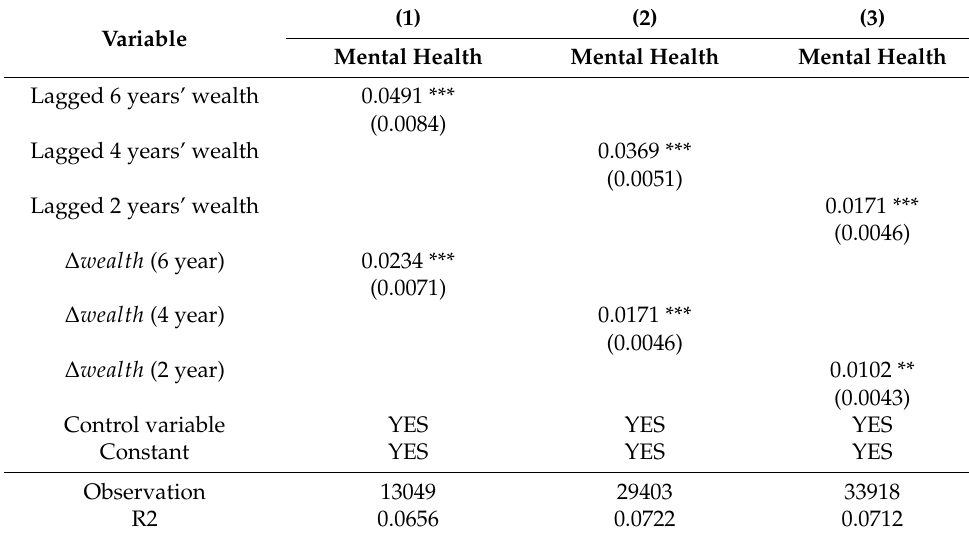
Table 9. The further analysis